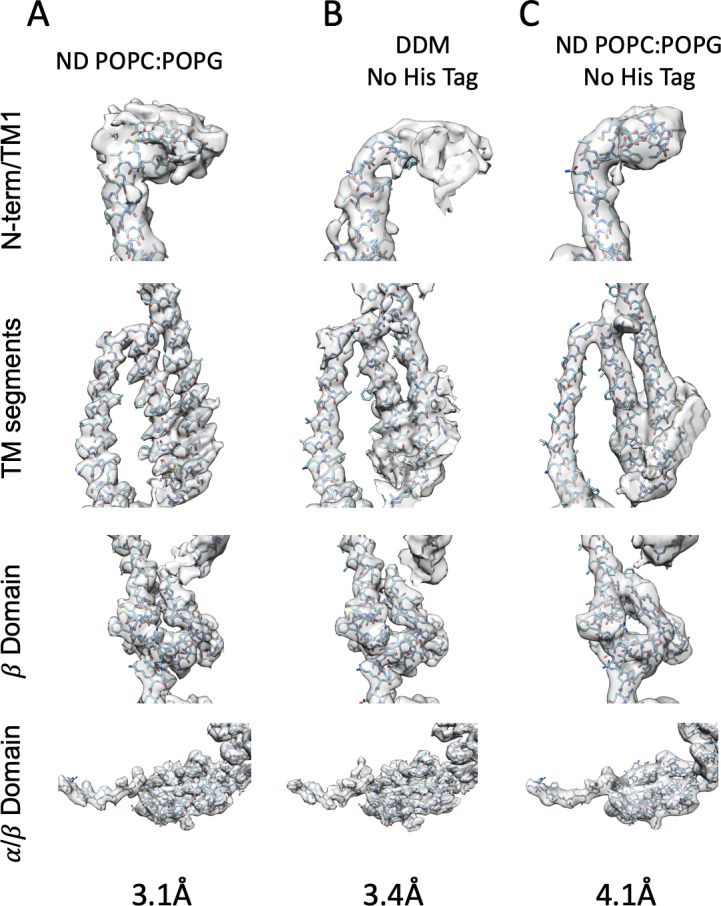
Model Fit to Density.(A) MscS ND (B) DDM (C) MscS ND No His-Tag.